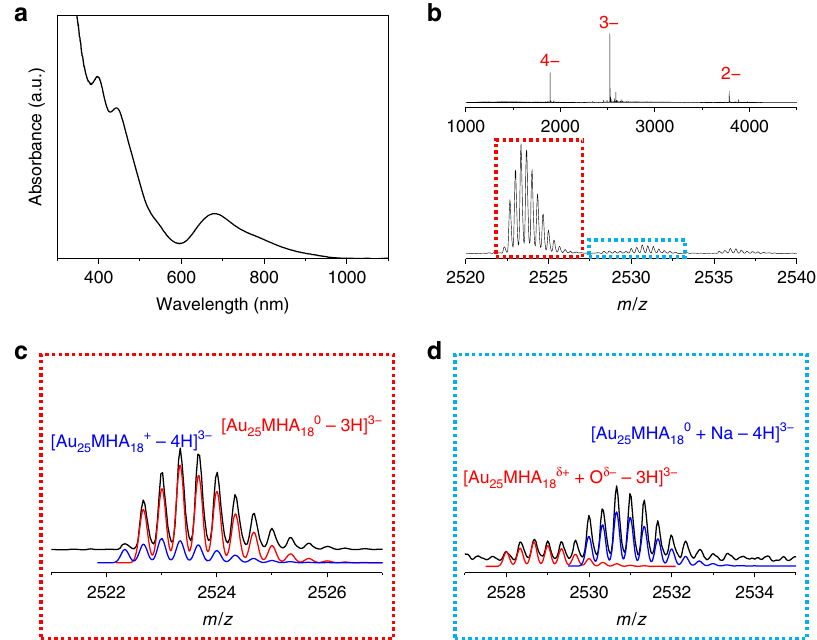
Fig. 3 Monitoring of reaction intermediates. a UV-Vis absorption and b ESI-MS spectra of [Au 25 MHA 18 ] species after PAGE puri fi cation and long-time exposure in air. Detailed analysis of the enlarged parts in red and blue square is shown in c and d , respectively. Both experimental and simulated isotopic patterns of labeled species are